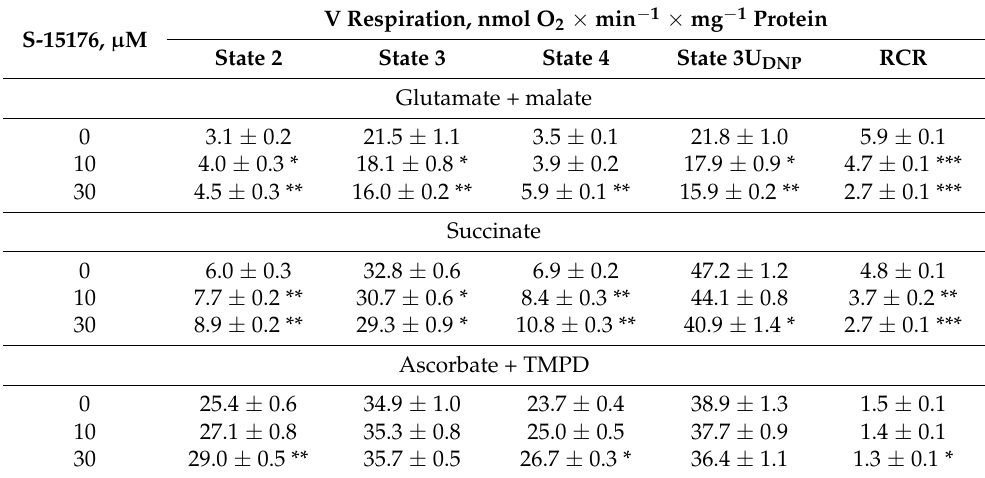
Table 1. Effects of S-15176 difumarate salt on the respiration of rat liver mitochondria. S-15176, µ